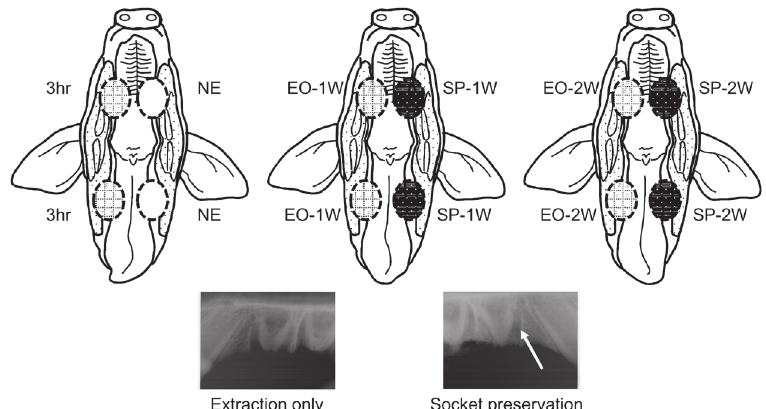
Figure 1- Overview of the animal experiment presented with a schematic drawing of swine oral cavity. Circles of dotted outline represent the following; 3hr: 3 hours after the extraction, right premolar extraction sockets; NE: no extraction/ control, left premolars; EO-1W: extraction only, 1 week post-extraction; SP-1W: extraction and socket preservation, 1 week after the procedures; EO-2W: extraction only, 2 weeks post-extraction; SP-2W: extraction and socket preservation, 2 weeks after the procedures. Arrow indicates socket filled with the graft material of biphasic calcium